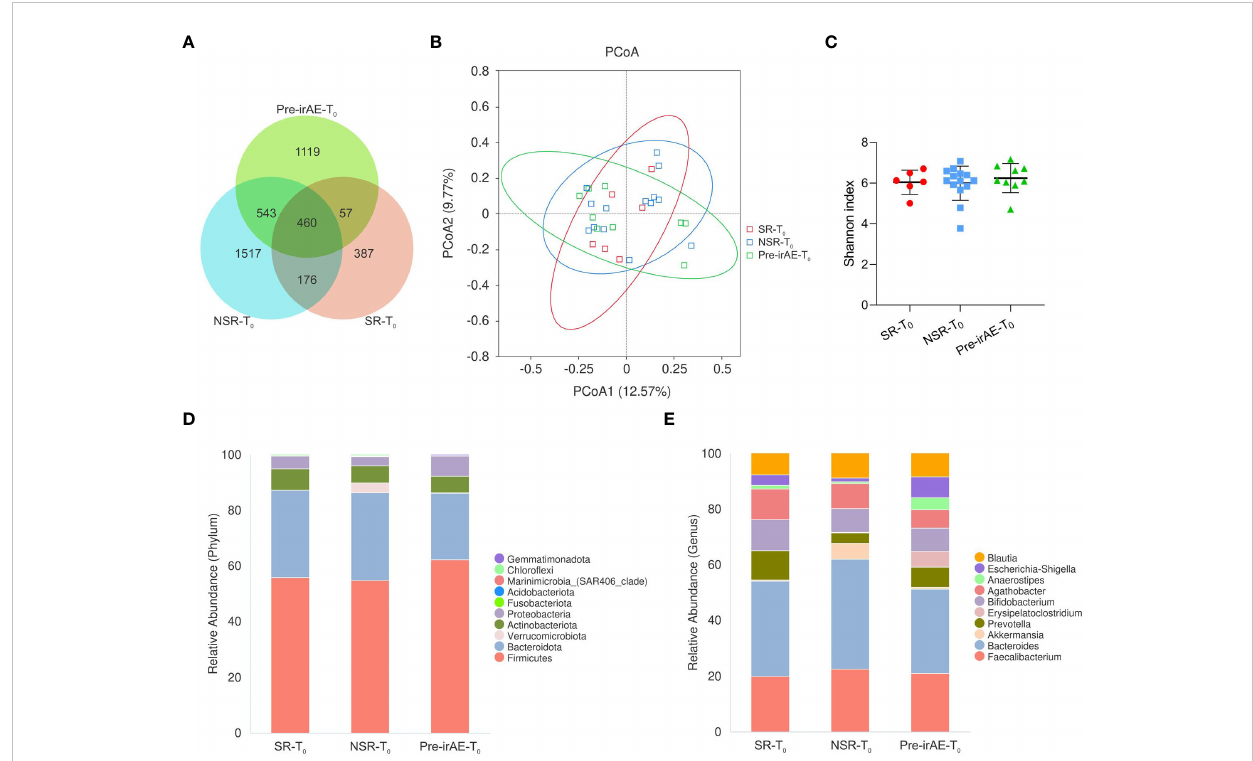
FIGURE 2 The baseline intestinal microbiota of patients with/without secondary resistance and irAEs. Fecal samples were collected at baseline from SR patients (SR-T 0 ), NSR patients (NSR-T 0 ), and irAE patients (Pre-irAE-T 0 ) before ICI treatment. (A) Venn diagram of ASVs; (B) PCoA plot using the Bray-Curtis dissimilarity matrix; (C) a -diversity by Shannon index, with bars representing mean and standard deviation; (D) Histogram of intestinal microbiome relative abundance with the top 10 phyla. (E) Histogram of intestinal microbiome relative abundance with the top 10 genera. ASVs, amplicon sequence variants; ICI, immune checkpoint inhibitor; irAE, immune-related adverse event; NSR-T 0 , non-secondary resistance patients - before ICI treatment; PCoA, principal coordinates analysis; Pre-irAE-T 0 , irAE patients - before ICI treatment; SR-T 0 , secondary resistance patients - before ICI